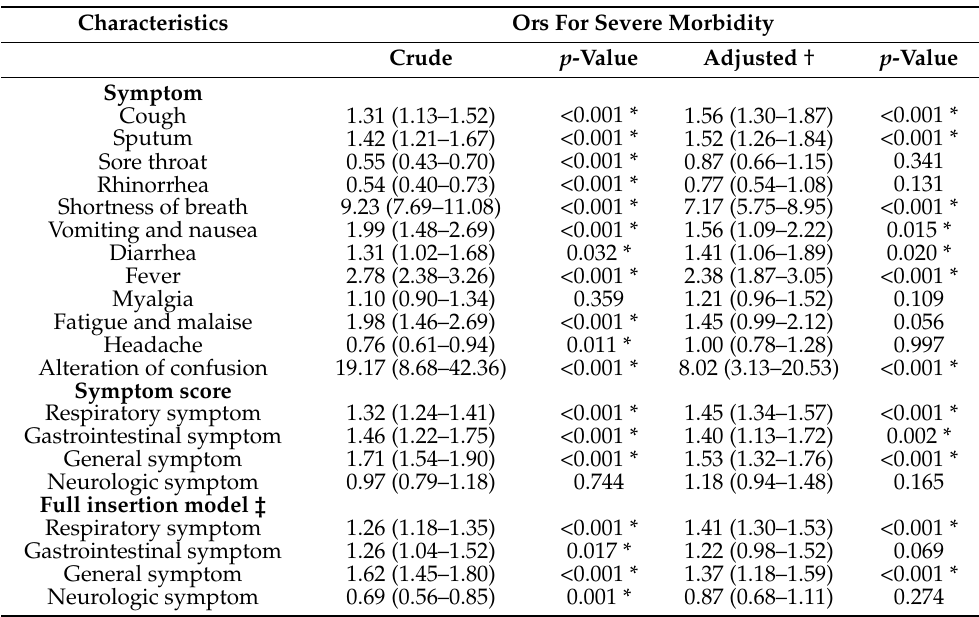
Table 3. Crude and adjusted odds ratios (95% confidence interval) for severe morbidity during the